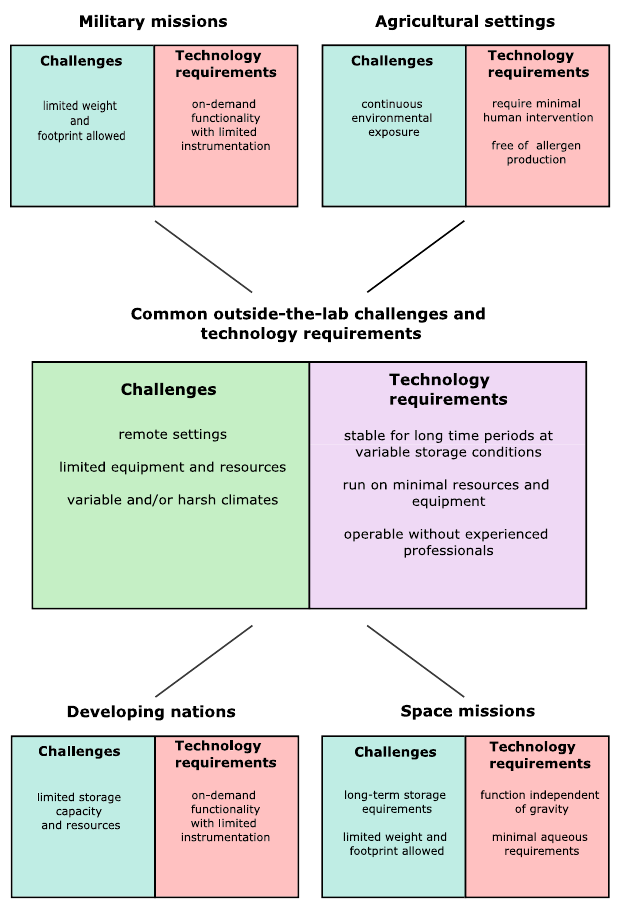
Fig. 1 Overview of major challenges and requirements for deploying synthetic biology-based platforms in outside-the-lab settings. Outside- the-lab scenarios have wide-ranging challenges and requirements for synthetic biology that are more demanding than typical laboratory settings.